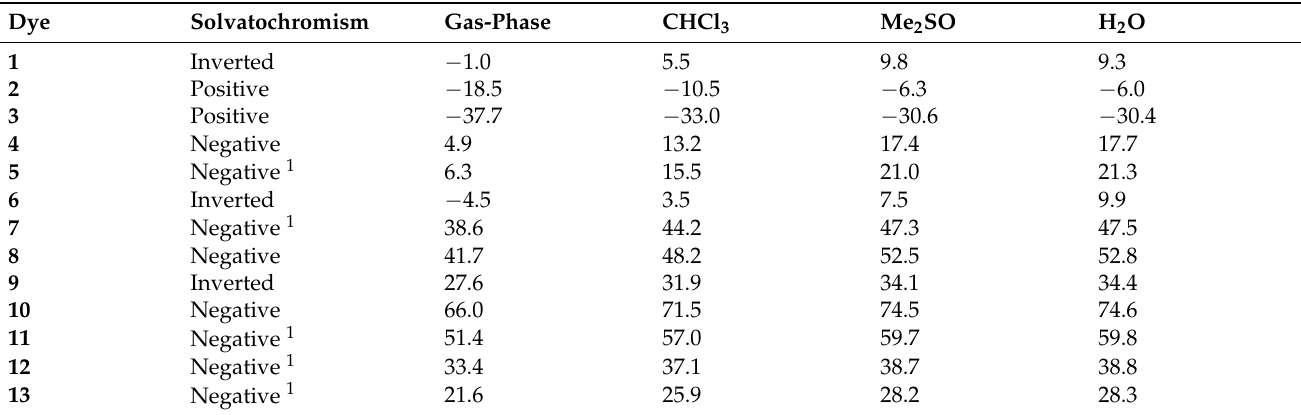
Table 2. Percentile difference between the electronic density participation of fragments X and Y in the HOMO and LUMO (CT) of dyes with the general formula